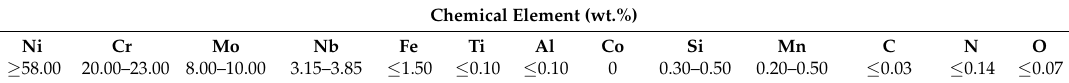
Table 1. Chemical composition of the Inconel 625 sample produced by directed energy deposition using a laser